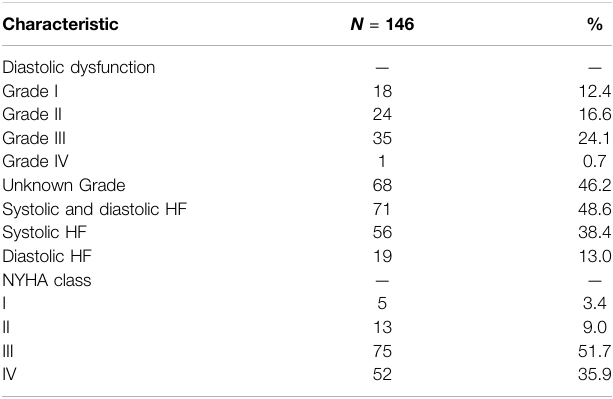
TABLE 6 | Medications on